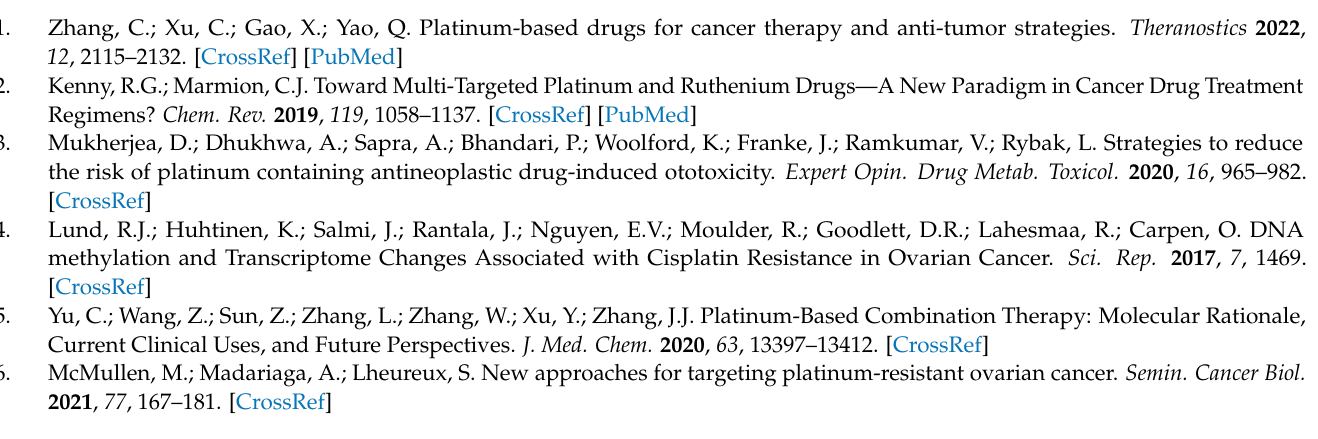
Table S1. Changes in the chemical shifts of selected 1 H NMR resonances as a result of complex formation; Table S2. Distribution coefficient of the synthesized complexes (logD); X-Ray diffraction study of Ru-3a : Figure S1. Ball-and-stick model of Ru-3a with a partial numbering scheme, Table S3. Experimental details, Figure S2. Packing diagram of Ru-3a , Table S4. Hydrogen-bond geometry (Å, º) for Ru-3a , Table S5. Geometric parameters (Å, º) for Ru-3a